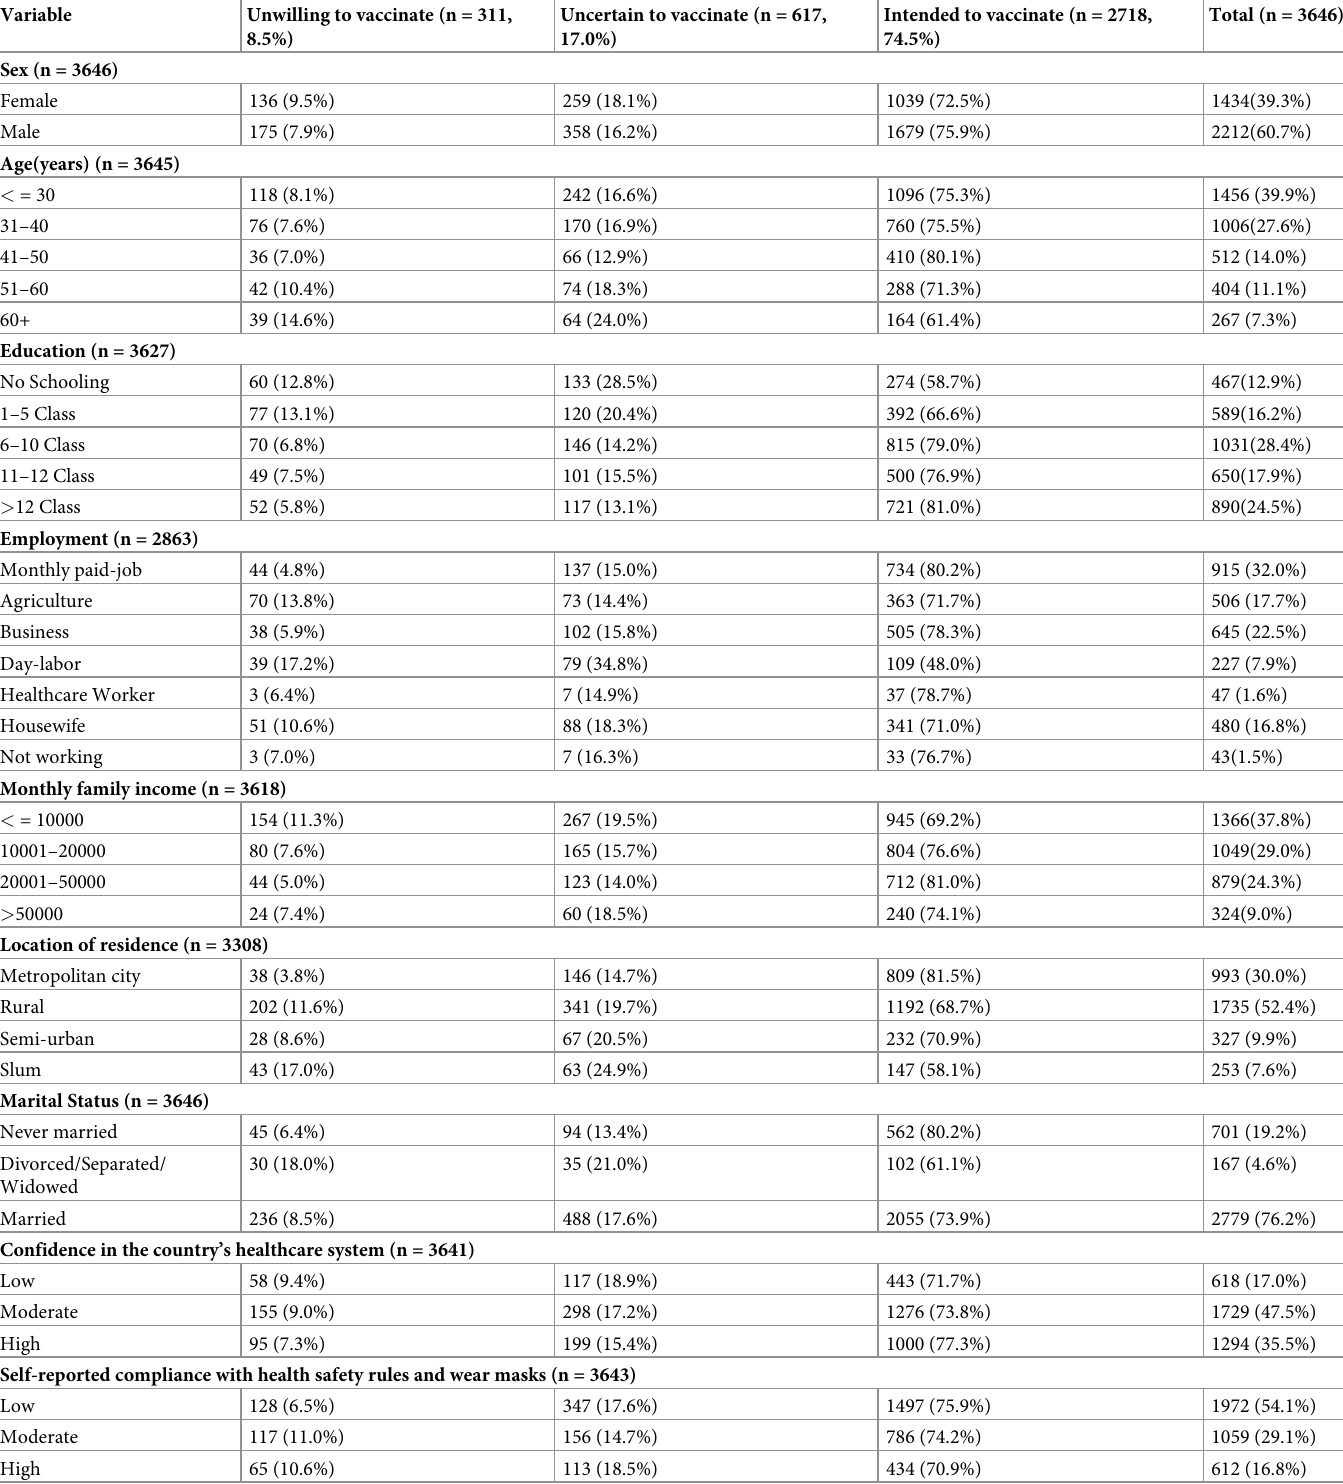
Table 1. Distribution of vaccine acceptance, hesitancy, and unwillingness by socio-demographic groups of the